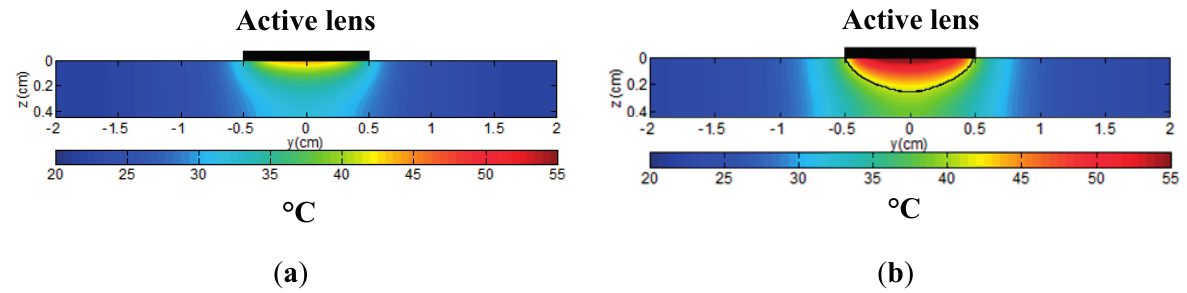
Figure 5. Two-dimensional temperature distribution in tissue. The active diffusion tip is along the y direction, while the z direction is perpendicular to the active